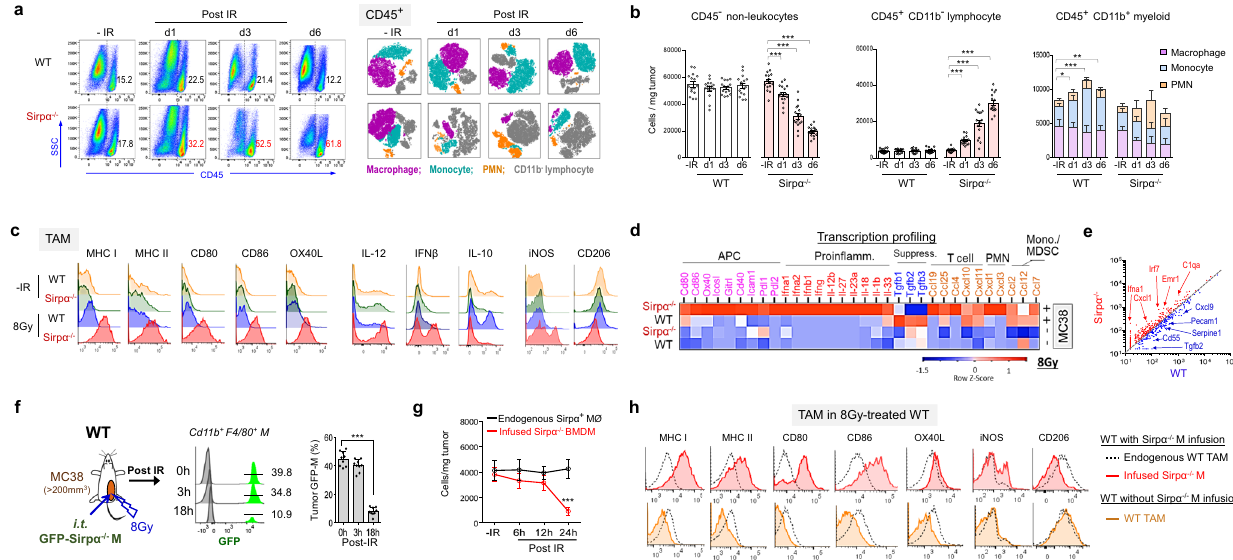
Fig. 3 Irradiation-activated Sirp α − / − macrophages drive a proin fl ammatory TME. a MC38 TME in (tumor > 200mm 3 ) WT and Sirp α − / − mice prior to and after 1 × 8 Gy were analyzed for CD45 + leukocytes (left panel), in which other immune populations were displayed by t-SNE (right panel). Data are representative of fi ve independent experiments ( n = 5 mice/group in each experiment). b Number of CD45 − non-leukocytes, CD45 + CD11b − lymphocytes, CD45 + CD11b − myeloid cells, and different myeloid cells subpopulation (F4/80 high Ly6C - macrophage , F4/80 + Ly6C + monocyte and Ly6G + PMN) in WT and Sirp α − / − MC38 TME. Data from fi ve independent experiments (3 – 4 mice in each experiment) are presented as mean ± SEM. n = 16 mice in each group. * P = 0.023, ** P = 0.008, *** P < 0.001. c Analyses of tumor-associated macrophages (TAM) in MC38 tumors of WT and Sirp α − / − mice. TAM in MC38 tumors of WT and Sirp α − / − mice were analyzed for antigen presentation machinery, in fl ammatory phenotypes, and M1/M2 marker prior to ( − IR) and 12 h post-IR (8 Gy). Cell-surface staining: MHC-I/II, CD80/86, OX40L, and CD206; intracellular staining: IL-12, IFN β , IL-10, and iNOS. Data represent three independent experiments. n = 10 mice in each group. d , e Tumor mRNA pro fi ling before and 12 h post-IR by Nanostring (nCounter